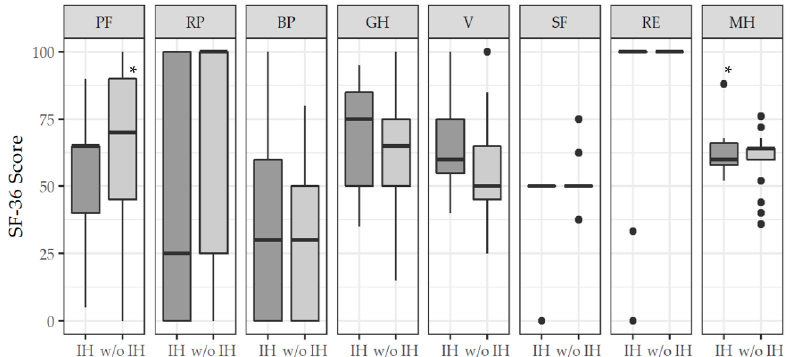
Figure 3. SF-36 score in patients after open repair of an abdominal aortic aneurysm. The health- related quality of life was assessed depending on the occurrence of incisional hernia (IH) compared to patients without incisional hernia (w/o IH), respectively. Data are given as median and IQR (25% and 75% percentile). Dots represent suspected outliers ( ≥ 1.5 IQR). Mood’s median test. * p < 0.05 vs.